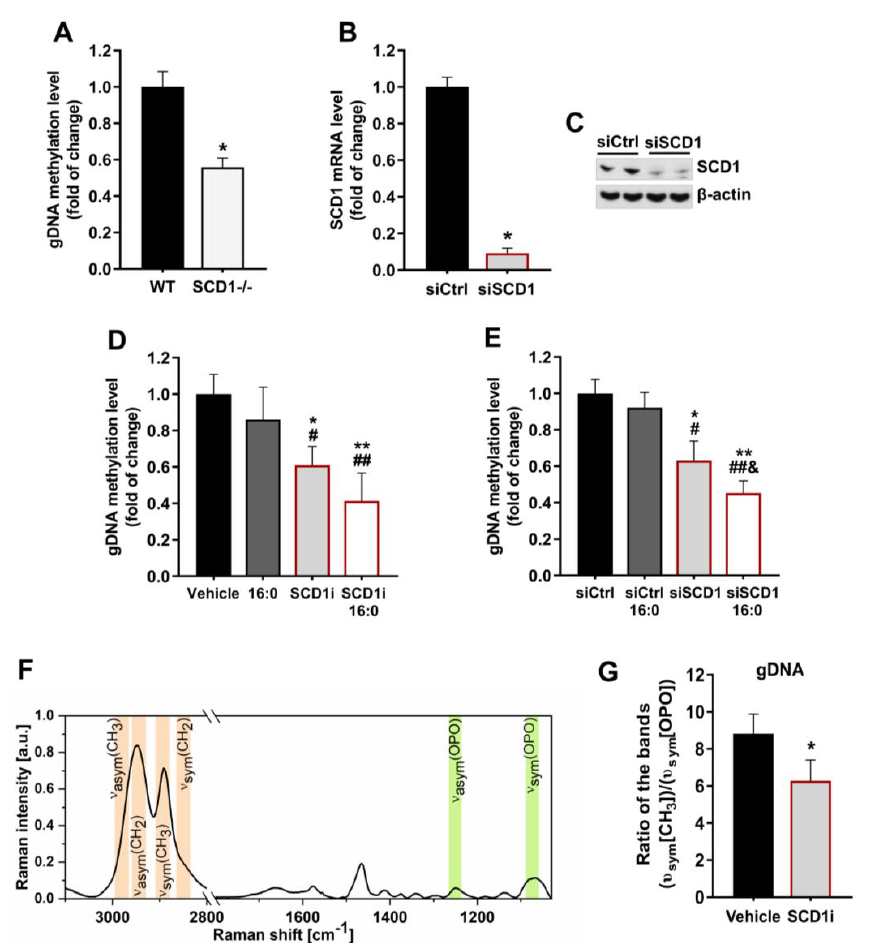
Figure 1. Stearoyl-CoA desaturase 1 (SCD1) downregulation leads to global DNA (gDNA) hypomethylation in pancreatic islets and INS-1E cells. ( A ) gDNA methylation level in pancreatic islets that were isolated from wildtype (WT) and SCD1 − / − mice. n = 6. * p < 0.05, vs. WT. ( B , C )